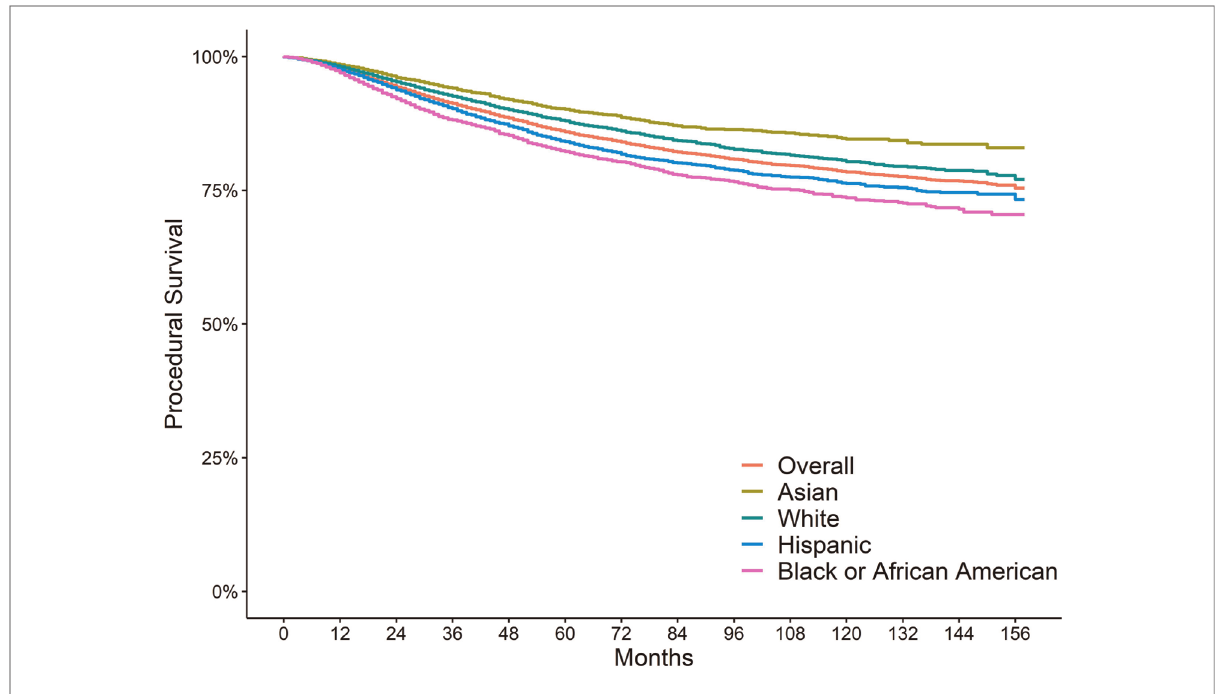
FIGURE 1 Survival of initial root canal therapy by